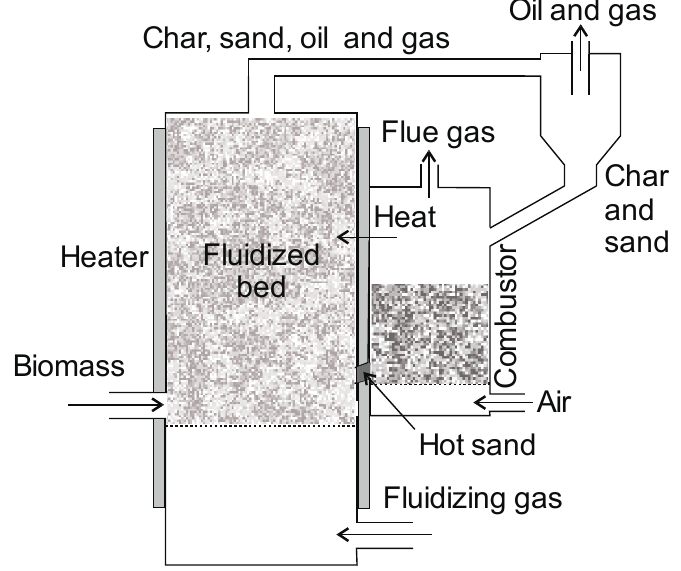
Figure 15. Circulating Fluidized Bed (CFB) (adopted from [136]).